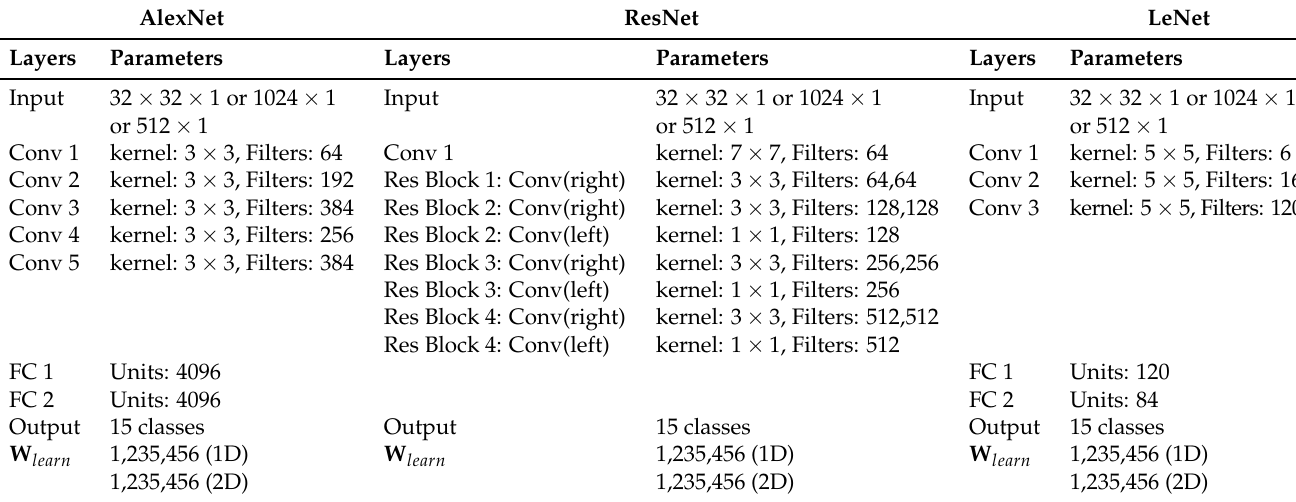
Table 3. Structural details of AlexNet, ResNet and LeNet used in this work.